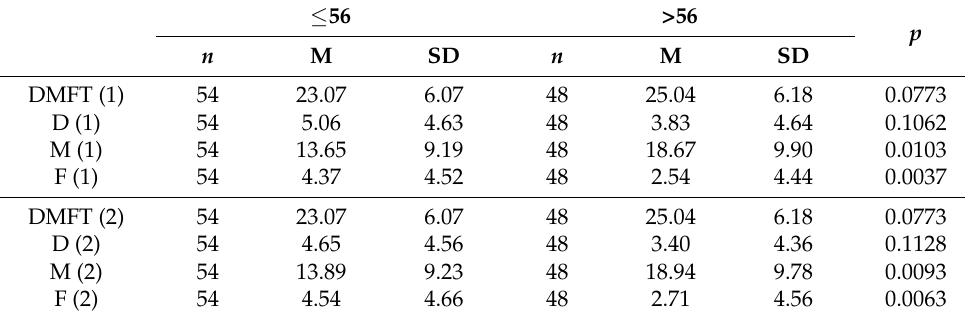
Table 12. Patients’ age and DMFT index before (1) and after (2) chemotherapy.